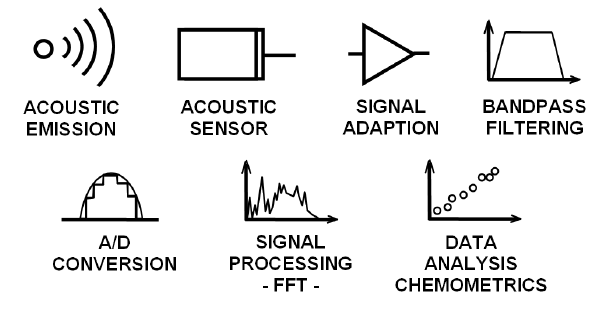
Figure 3: Schematic overview of acoustic